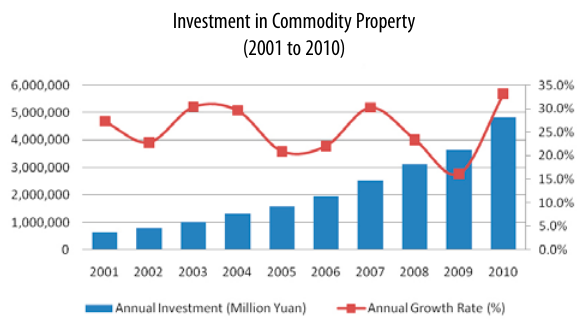
Fig. 2. Investment in commodity property